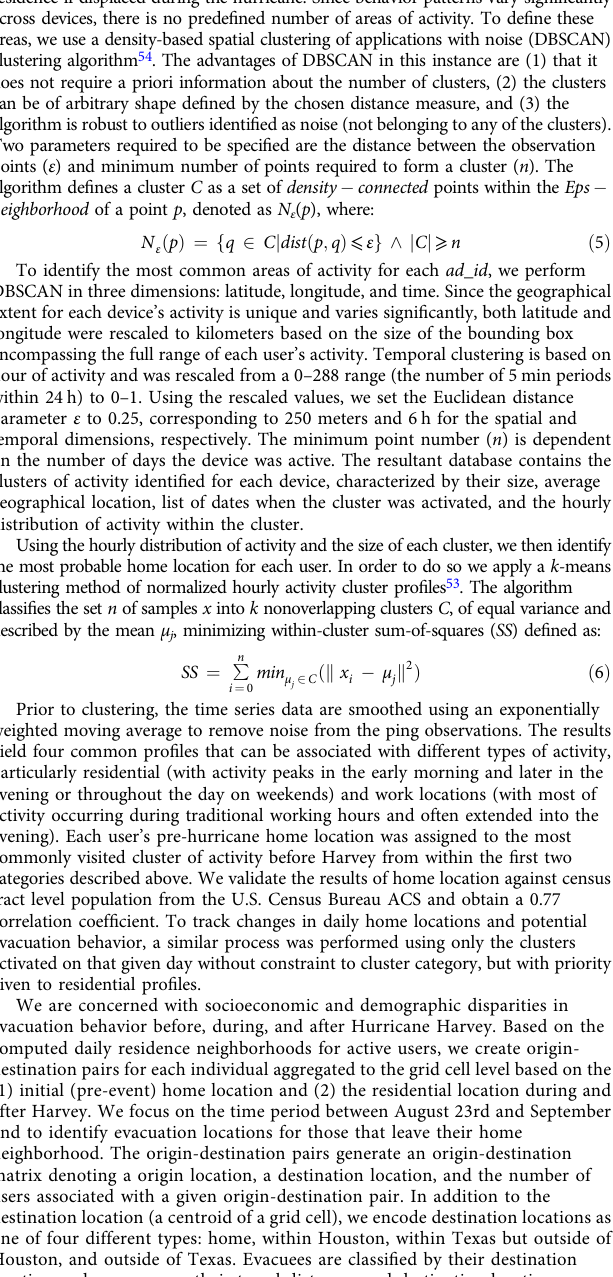
algorithm de fi nes a cluster C as a set of density − connected points within the Eps − neighborhood of a point p , denoted as N ε ( p ),